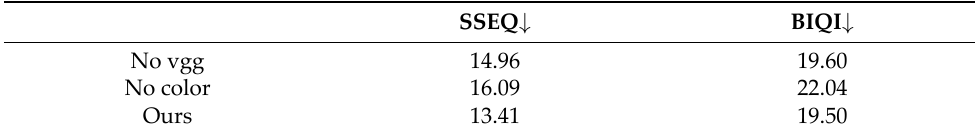
Table 2. Average SSEQ and BIQI scores for the different loss functions.